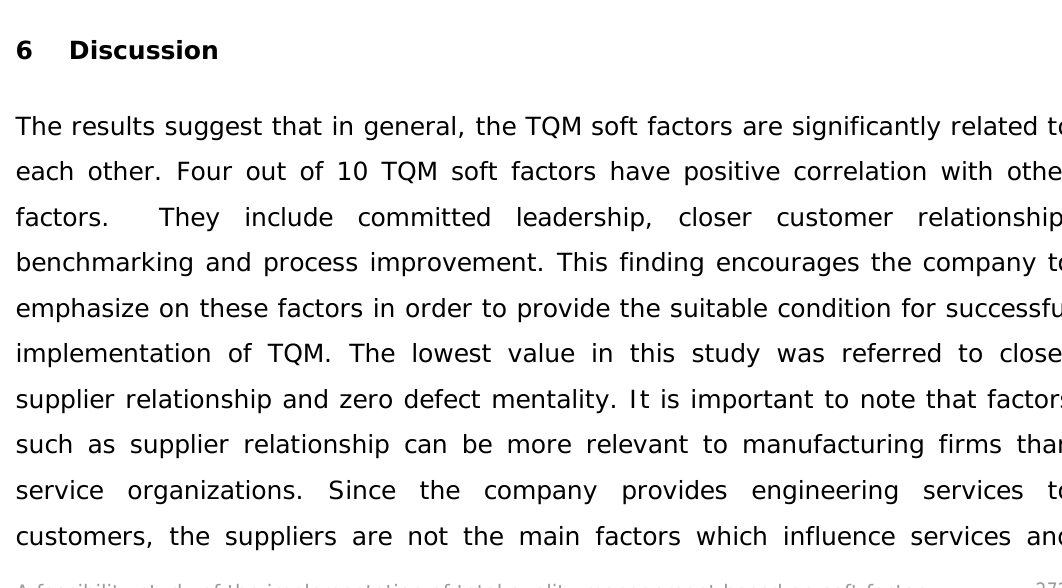
Table 4. "Two tailed Pearson correlation test of the TQM soft